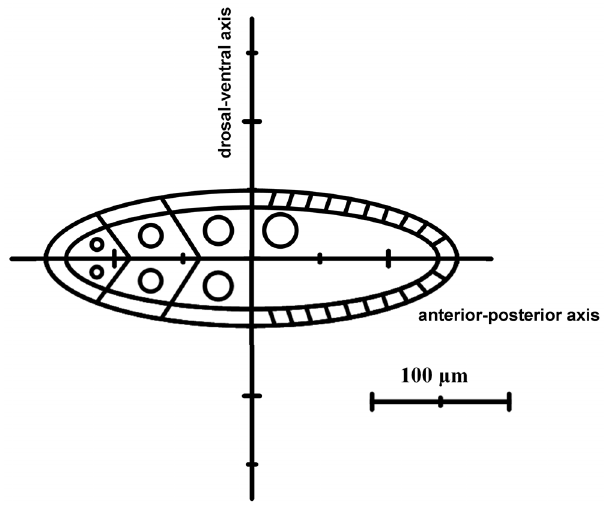
Figure 3. A schematic diagram of the stage 10A Drosophila oogenesis chambers with the anterior-posterior-axis and dorsal-ventral axis. The scale bar is 100 m m.